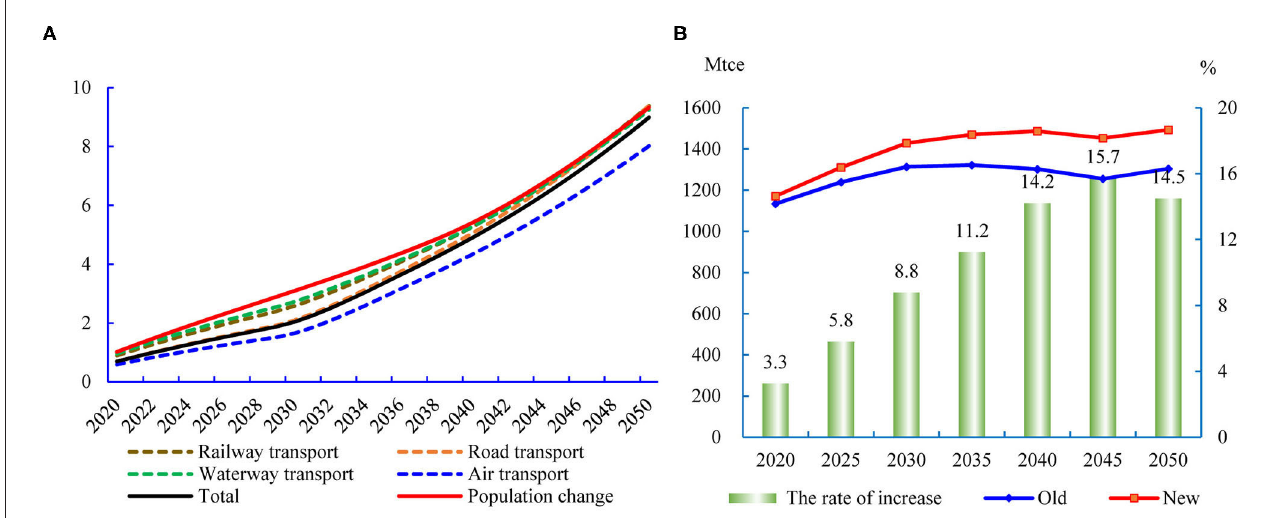
FIGURE 6 | Effect of the two-child policy on energy consumption in the transport sector. (A) The changes of energy consumption in the passenger transport sector (%). (B) Energy consumption in the freight transport sector.